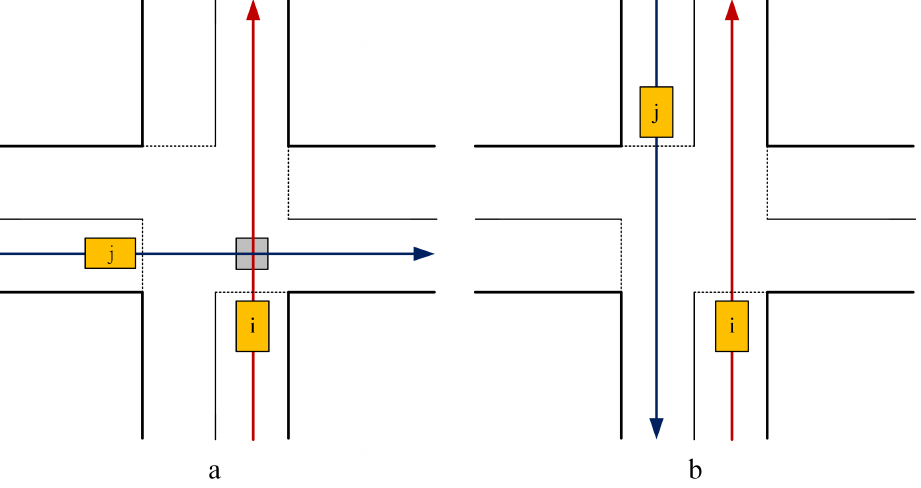
Figure 4. An example of interaction between two vehicles, where vehicle i has priority over vehicle j . ( a ) Trajectories of vehicle i and vehicle j have a possible collision. ( b ) Trajectories of vehicle i and vehicle j have no collision.